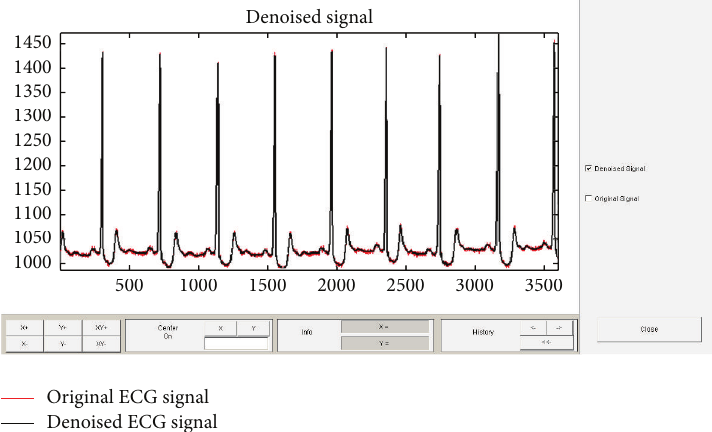
Figure 5: Original and denoised signals for ECG record no 114m using Biorthogonal wavelet.